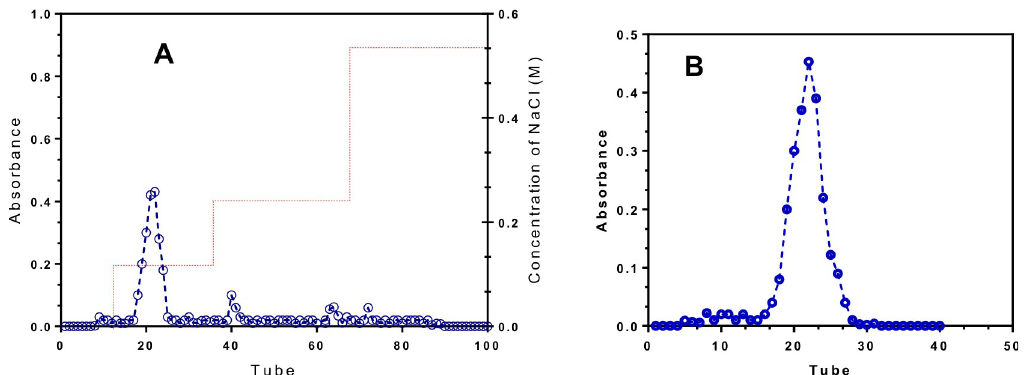
Fig 6. Chromatographic profile of POP. A) The elution profile of POP on DEAE-cellulose column and B) gel filtration elution curve of POP. POP, Pleurotus ostreatus polysaccharide.